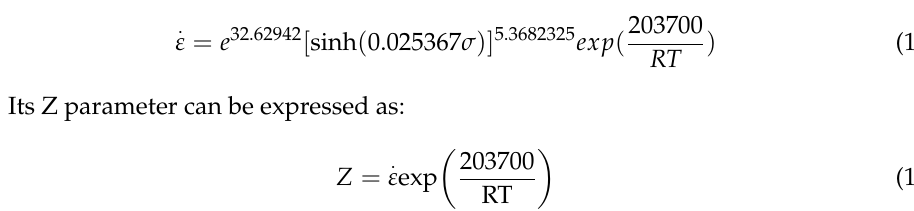
Figure 4. Correlation between lnZ parameter and ln[sin h( ασ )] under true strain of 0.5.